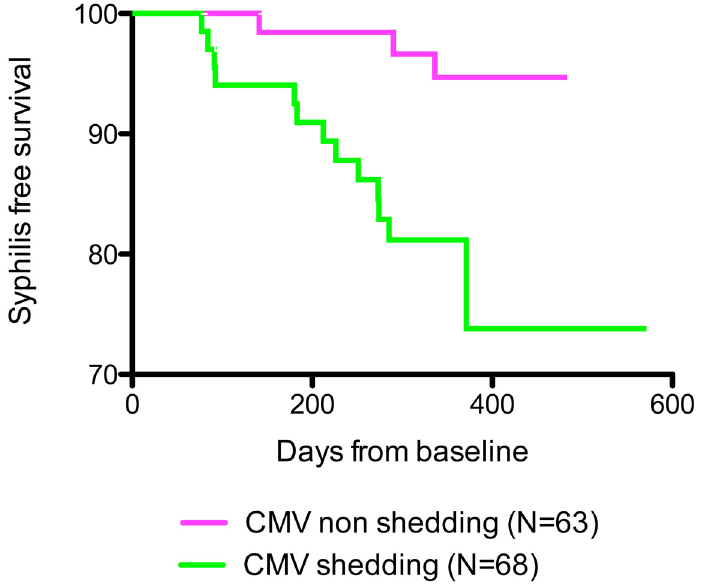
Fig 1. Kaplan Meier of Syphilis Cases. Kaplan Meier curve of time to incident syphilis during follow-up in subjects with detectable seminal CMV DNA (in green, N = 68) and without detectable seminal CMV DNA (in pink, N = 63) at